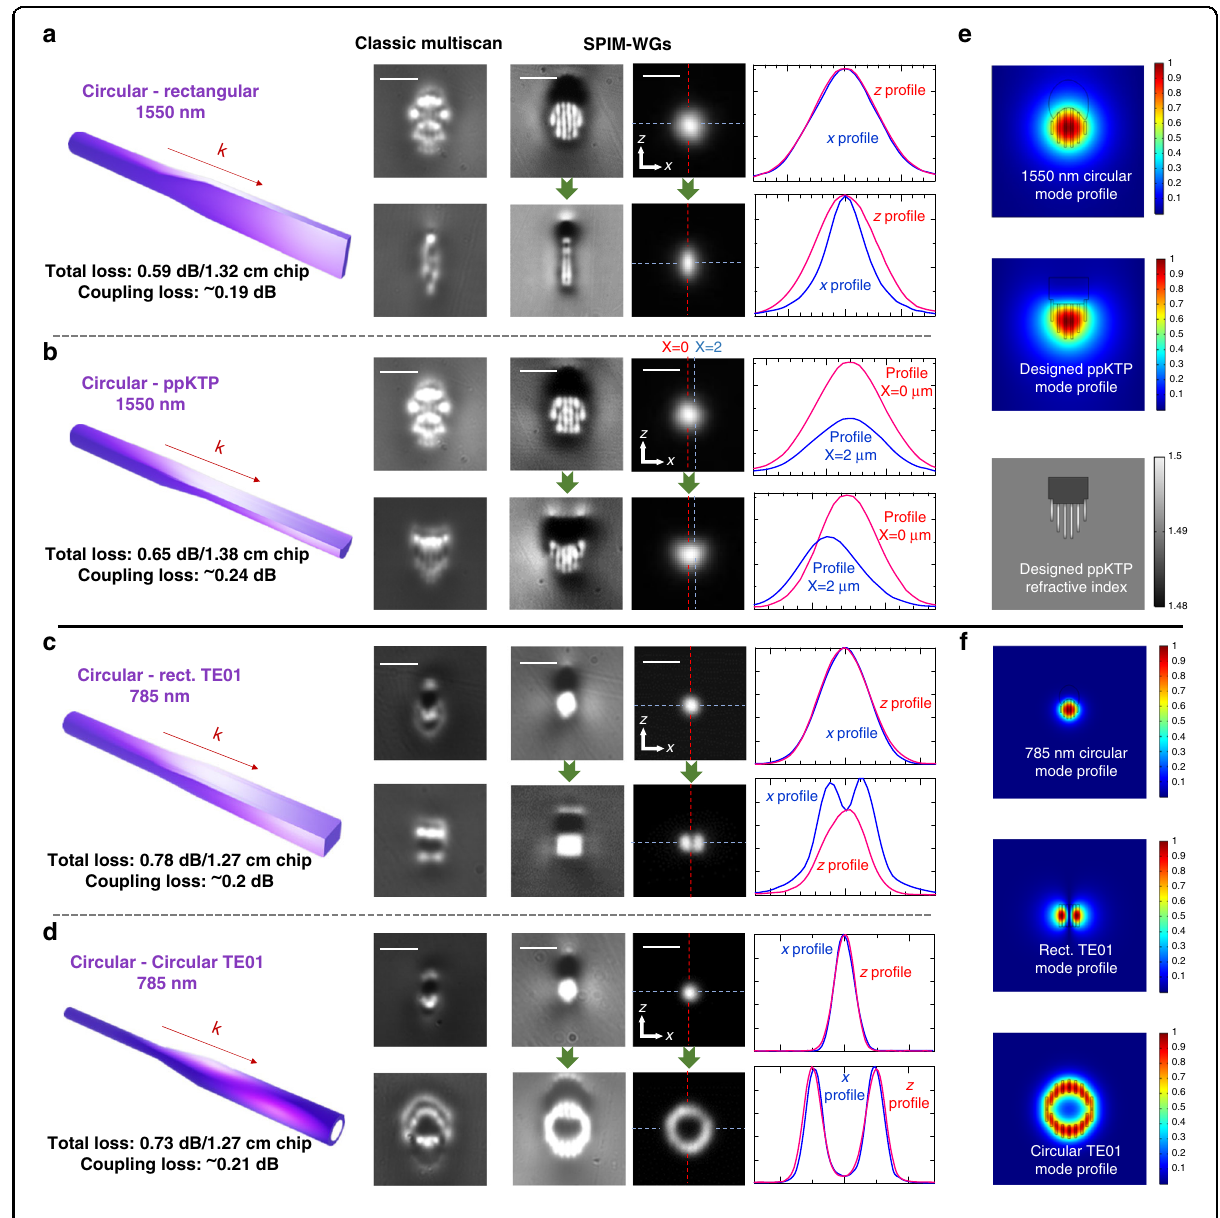
Fig. 4 (See legend on next